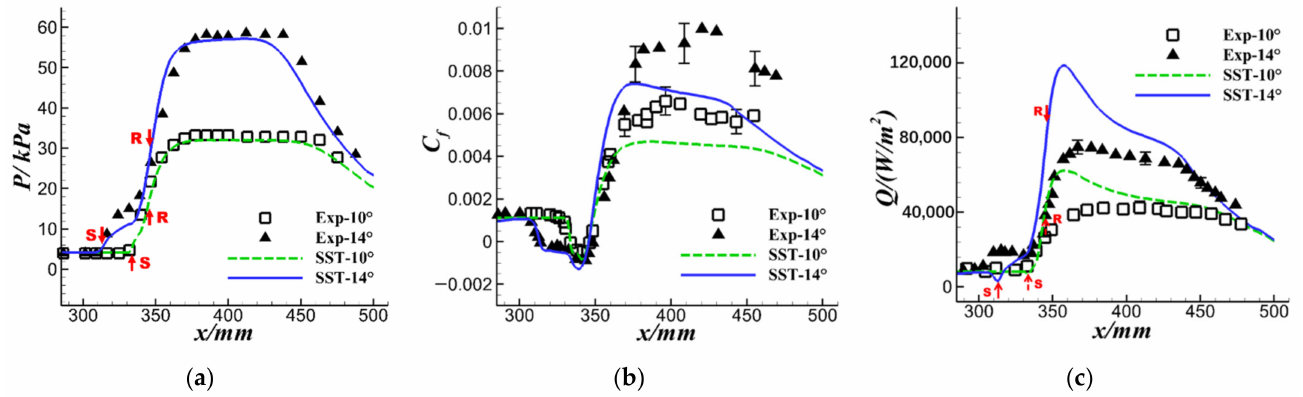
Figure 6. Comparison of the wall properties distribution between the experiment and simulation for the two cases. ( a ) Wall pressure; ( b ) skin friction; ( c ) wall heat